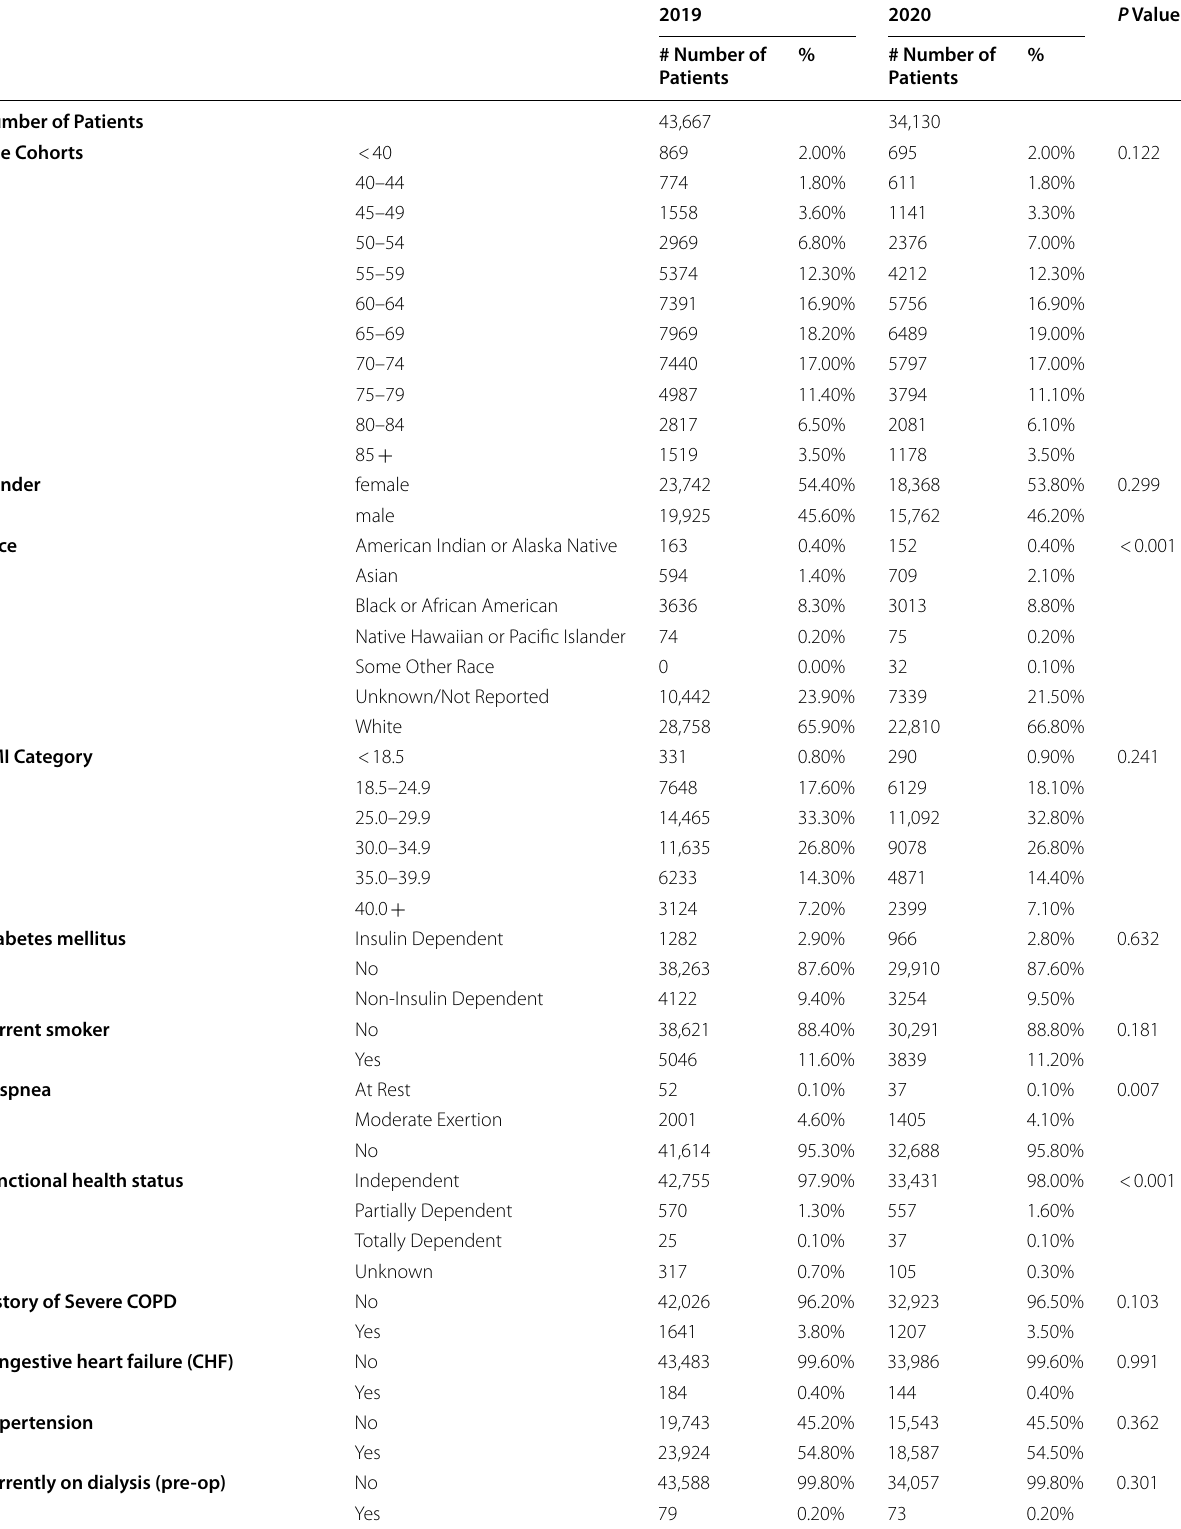
Table 1 Comparison of patient demographics in 2019 versus 2020 for elective